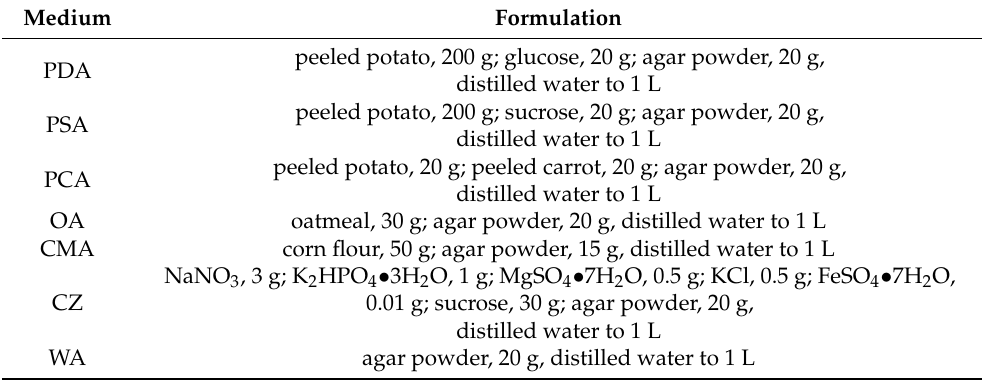
Table 2. Formulation of the